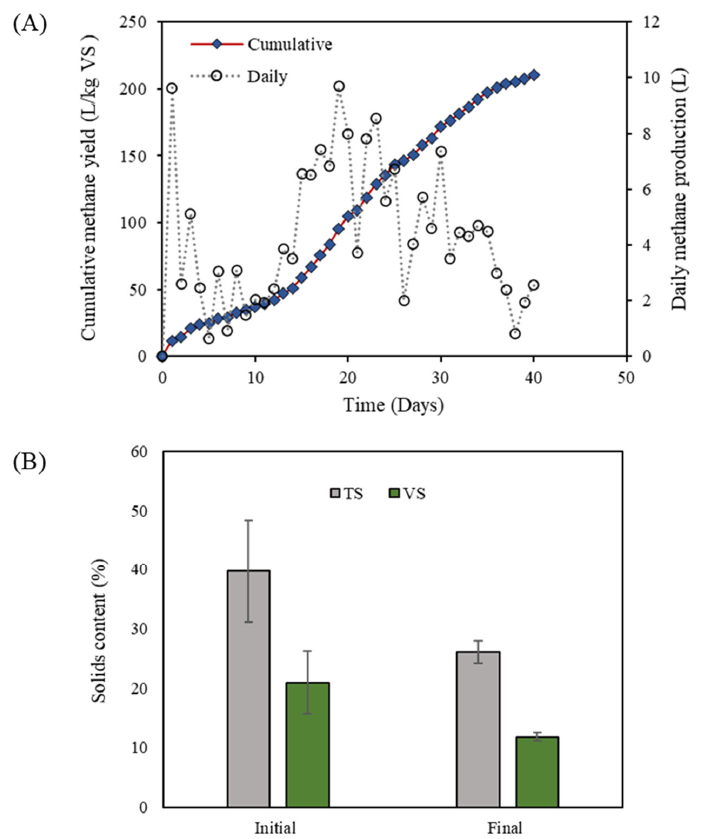
Figure 2. ( A ) Cumulative methane and daily methane production from the high ‐ solids anaerobic digestion (HSAD) reactor; ( B ) initial and final solids digestion (HSAD) reactor; ( B ) initial and final solids contents.